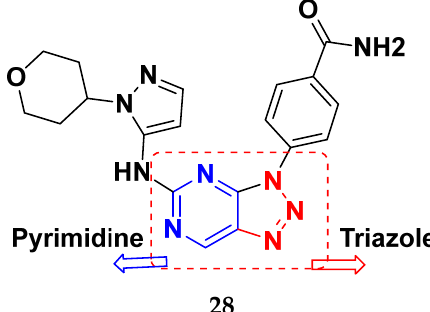
Figure 31. A pyrimidine-triazole based hybrid ( 28 ). El-Sayed et al. (2011) synthesized sulfonamide-thiazole fused pyrimidine deriva- tives, and evaluated their anticancer activity in amethyl green/DNA displacement assay.